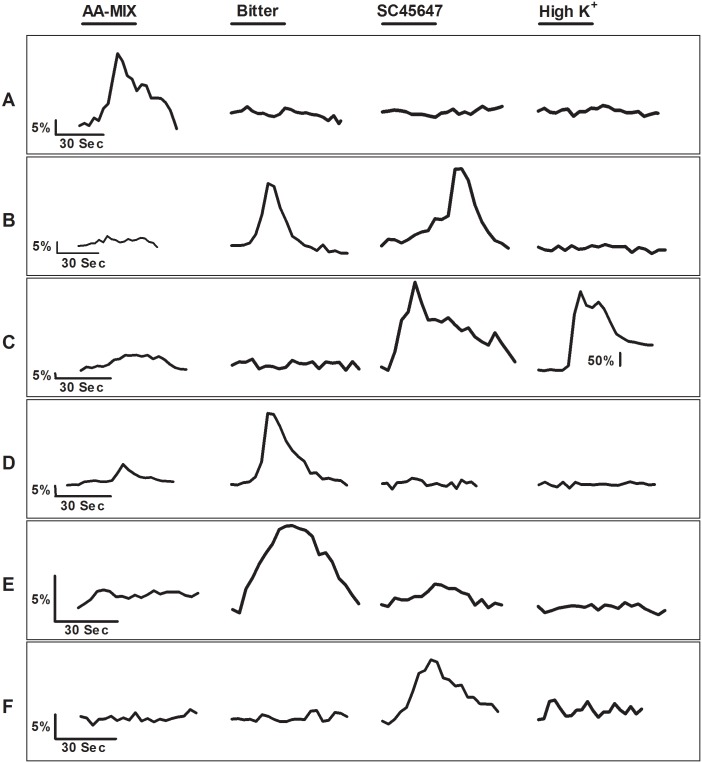
Representative Ca2+ responses elicited by TSCs during stimulation with 4 different stimuli.Cells were stimulated with 4 different stimuli, L-amino acid MIX (AA-MIX) (MPG (10mM), Ser (20mM), Arg (10mM), and Gln (10 mM)), sweet (SC45647 (100μM)), bitter (denatonium (2mM) or cycloheximide (20μM)+denatonium (2mM)), and high-K+ (65mM) solution. The bar above each stimulus trace represents the 30 s stimulus application period. [A] A TSC that responded only to AA-MIX. [B] A TSC that responded to bitter and sweet stimuli. [C] A TSC that responded to AA-MIX, sweet, and high-K+ solution. AA-MIX elicited a very small increase in cytosolic Ca2+ compared to sweet stimulus. The high-K+ solution elicited very large increase in cytosolic Ca2+, suggesting the presence to voltage-gated calcium channels. Note: A different Y axis scale was used for the high-K+ response as the high-K+ elicited response was much larger compared to AA-MIX or sweet responses. [D] This TSC responded to both AA-MIX and bitter stimuli. AA-MIX elicited a very small increase in cytosolic Ca2+ compared to bitter stimulus. [E] This TSC responded only to bitter stimuli. [F] This TSC responded only to sweet stimuli.